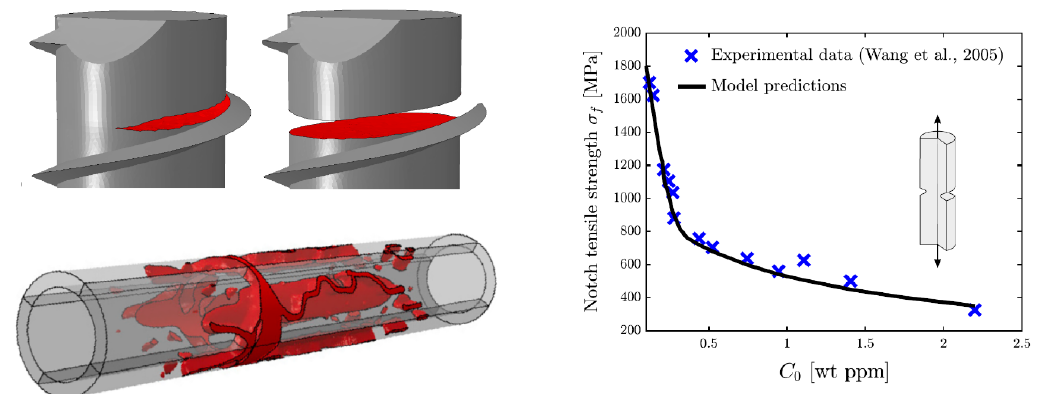
Figure 3. Phase field modelling of hydrogen embrittlement in a screw anchor, a pipeline with internal defects and in cylindrical notched bars. The results reported belong to Refs.